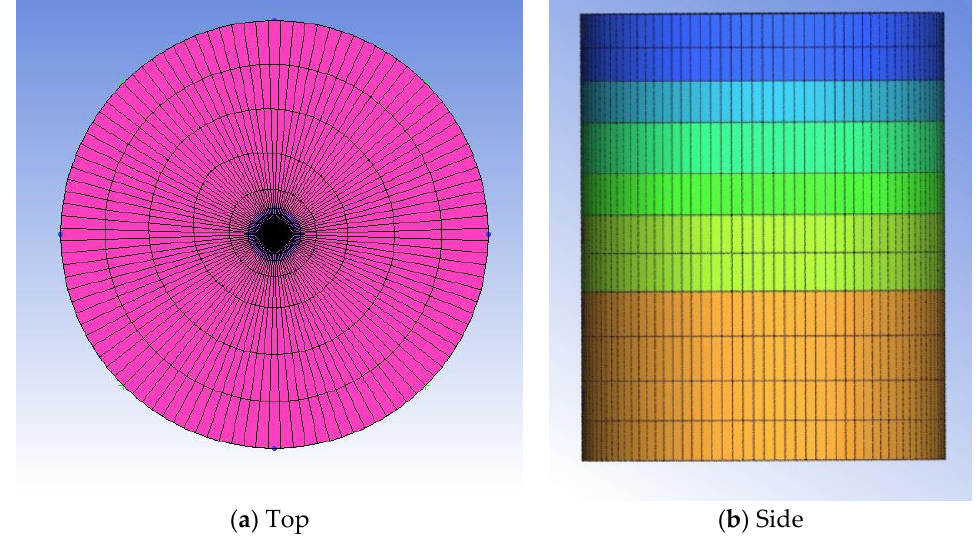
Figure 5. 3D computational model meshing.